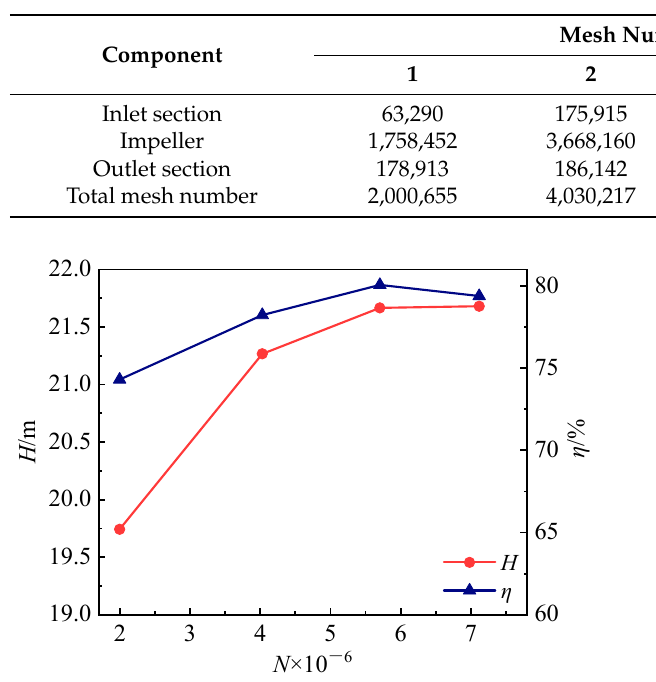
Figure 3. Mesh independence